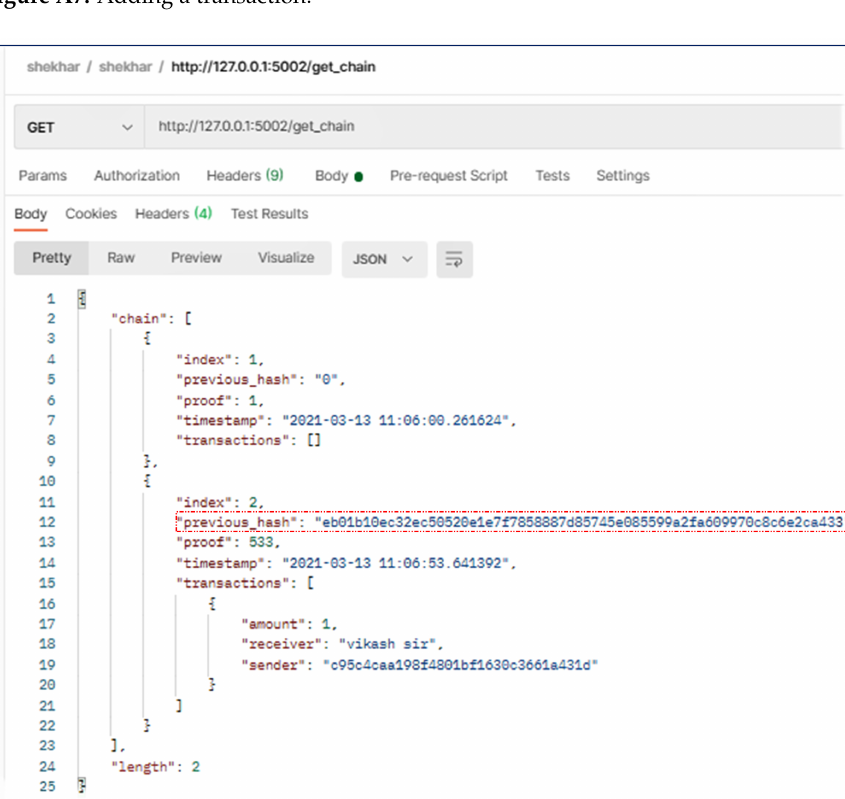
Figure A7. Adding a transaction.